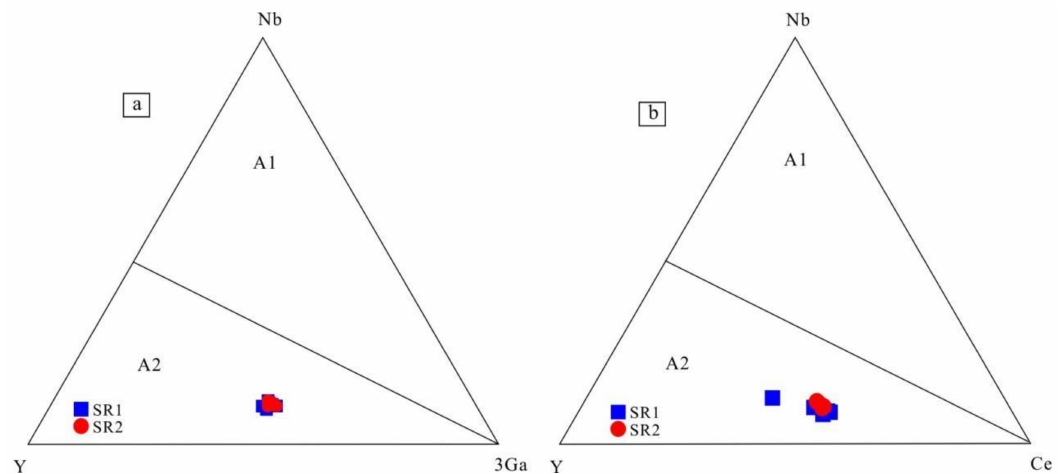
Figure 10. Y–Nb–3 Ga diagrams ( a ) and Y–Nb–Ce diagrams ( b ) for the medium-fine-grained granites and granite porphyry in the Sayashk Sn deposit (modified after